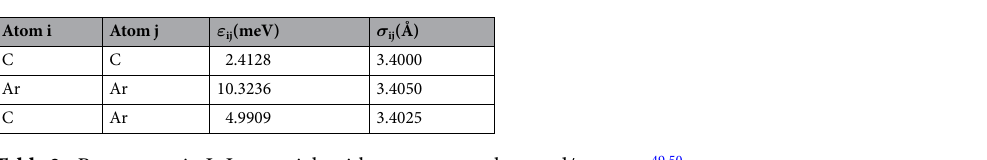
Table 2. Parameters in L-J potentials with respect to carbon and/or argon 49,50